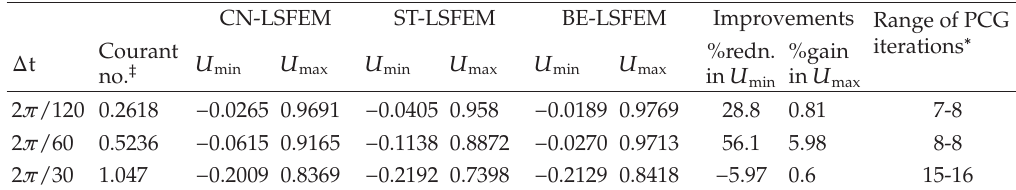
Table 4: Advection of cosine hill in